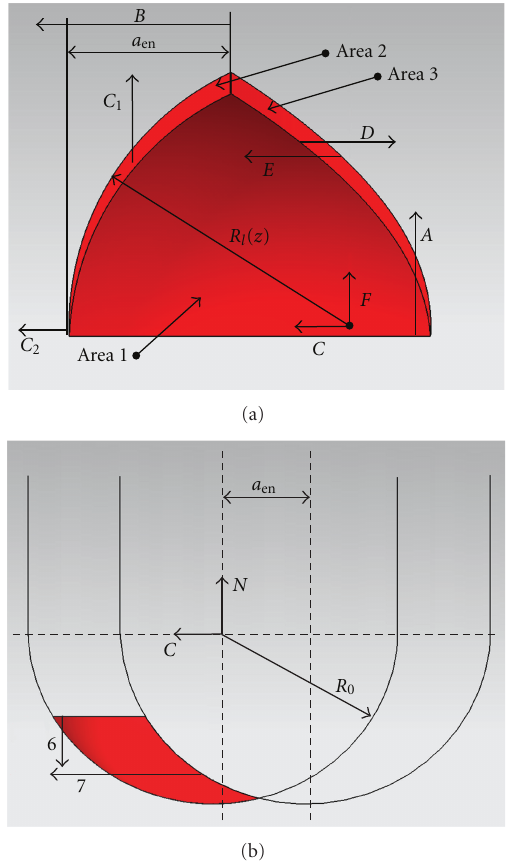
Figure 7: Definition of the boundary curves for the case